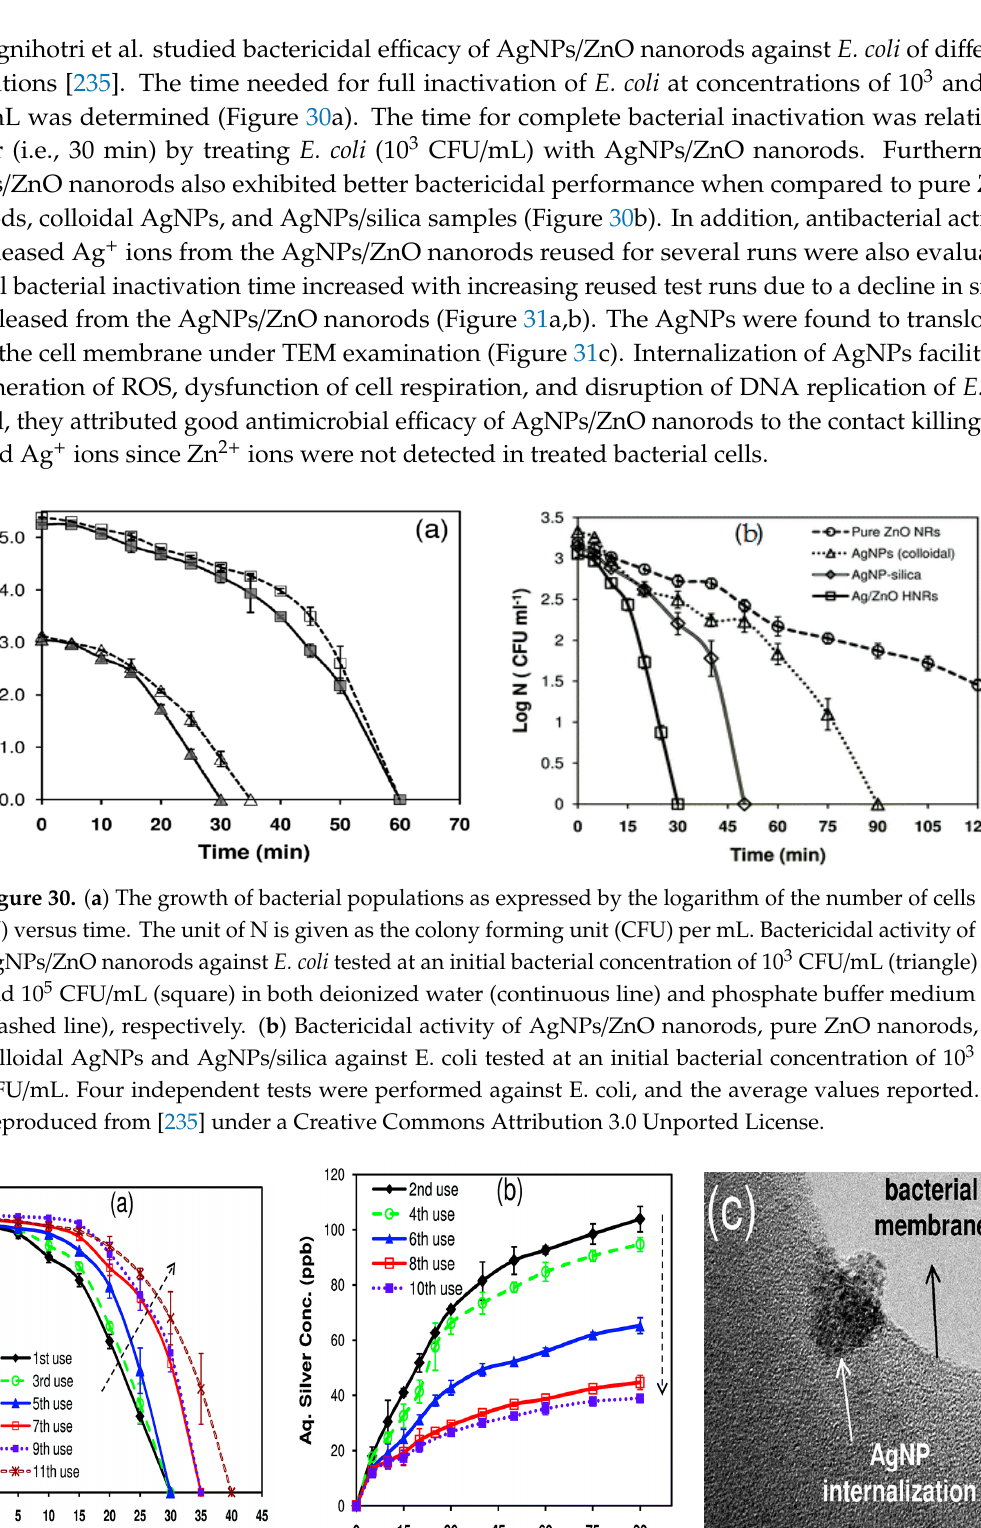
Figure 29. Antibacterial efficacy of pristine ZnO and Cu-doped ZnO nanorods using shake flask method. Reproduced from [103] with permission of Springer.